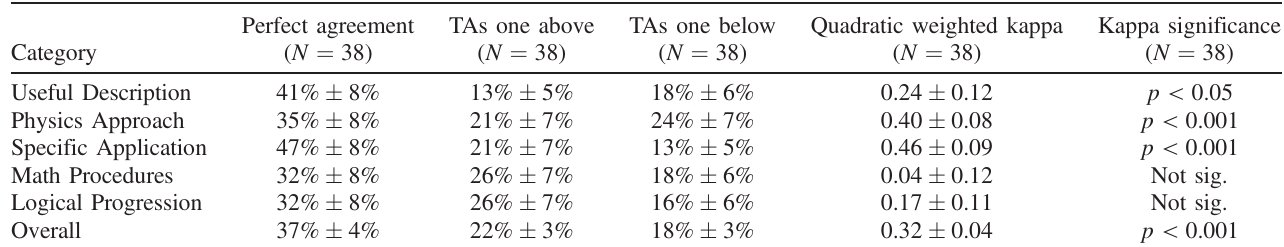
TABLE VIII. Percent agreement of first-year graduate students scores with rubric developer scores after a brief training activity. Overall agreement within one score is 77 % (cid:2) 3 %. N is the number of solutions scored by the participants ( 19 raters× 2 solutions).